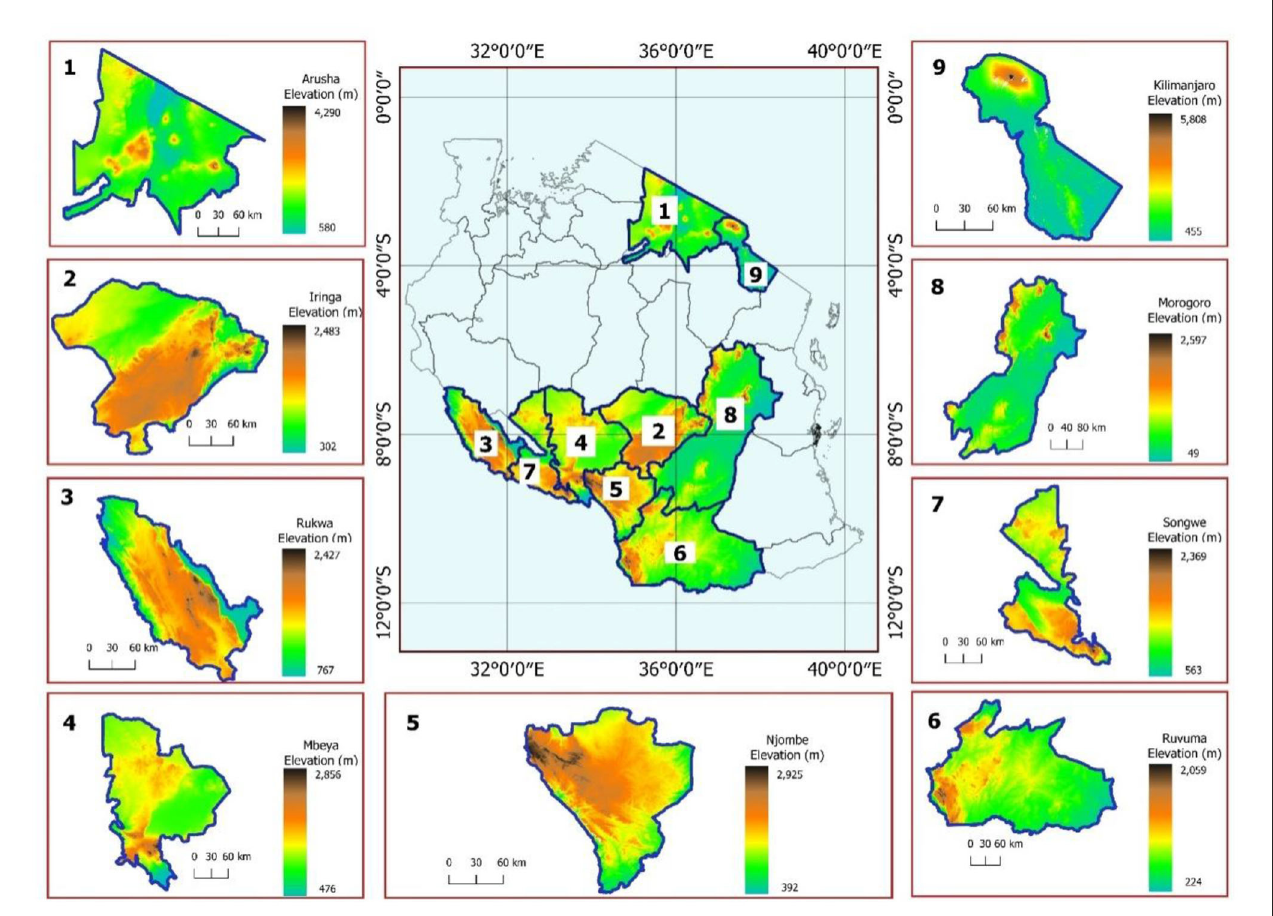
FIGURE1 The map showing maximum and minimum elevations of the regions where soils and nodules were sampled.